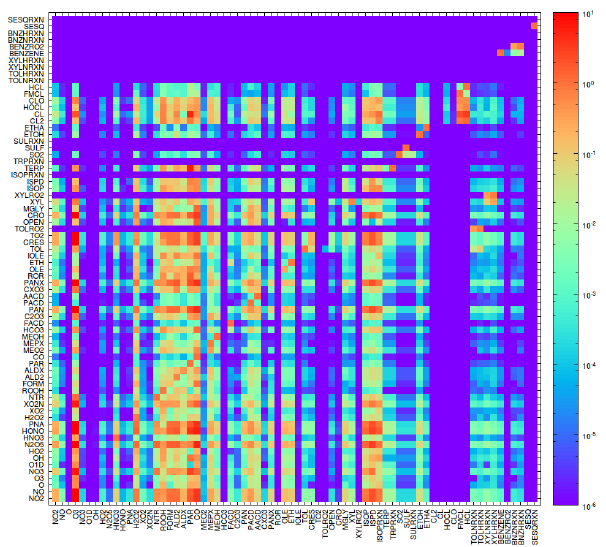
Figure 9. The Jacobians of absolute sensitivities from the ADJ of gas-phase chemistry at a grid cell from a one-step run. The x and y axes represent all species involved in gas-phase chemistry.